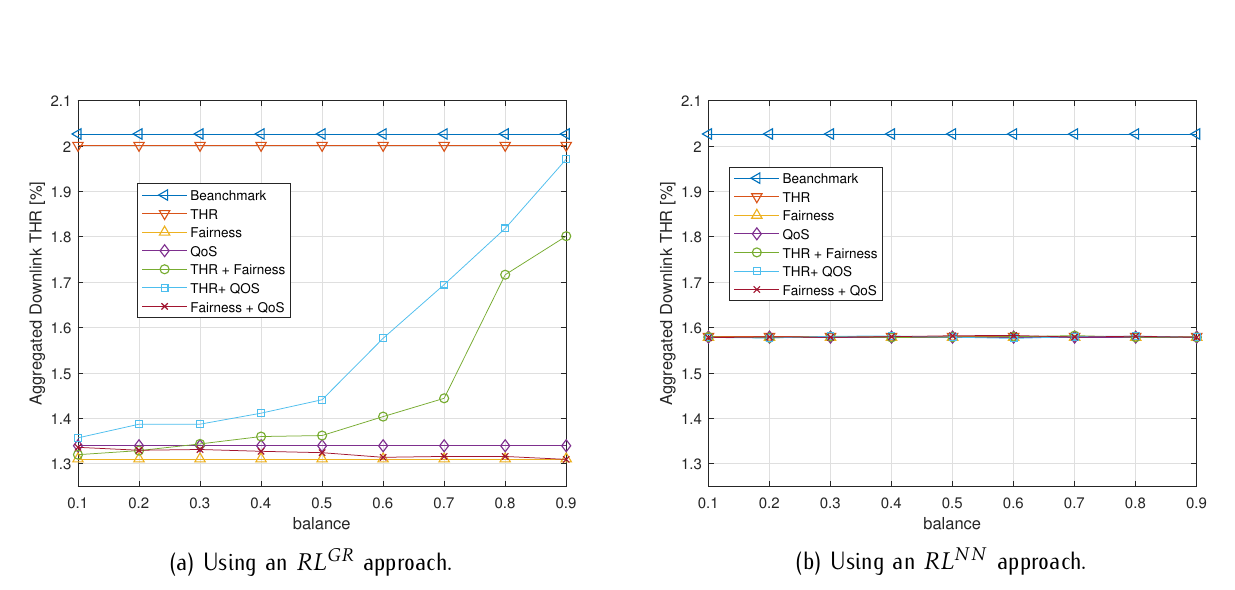
Figure 2. Percentage of downlink throughput respect to the T HR